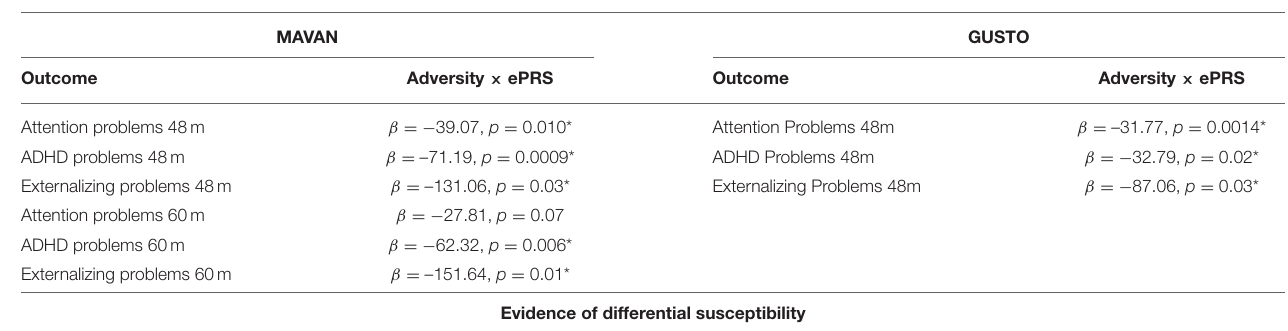
TABLE 3 | Results of interactions between the adversity score and the amygdala-based ePRS-5-HTT on CBCL behavior of children in MAVAN and GUSTO cohorts; and evidence of differential susceptibility. Interactions between the adversity score and the amygdala-based ePRS-5-HTT MAVAN